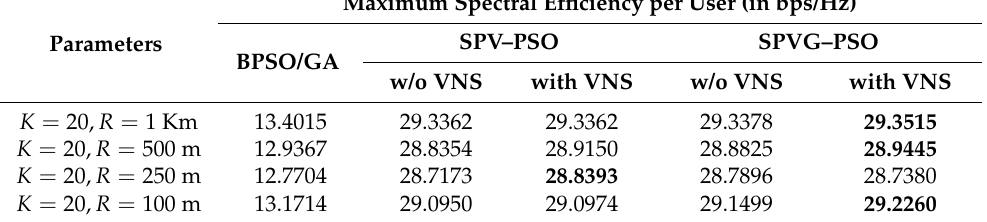
Table 6. Maximum spectral efficiency per user in different cell sizes. The best value for each algorithm is are marked in bold type.